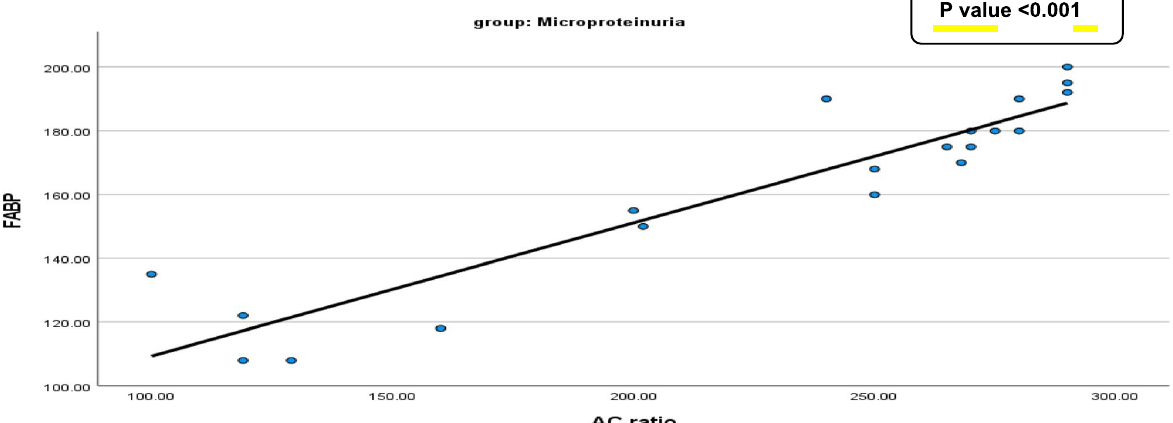
Fig. 1 Correlation between serum FABP4 and albuminuria in the microalbuminuria group